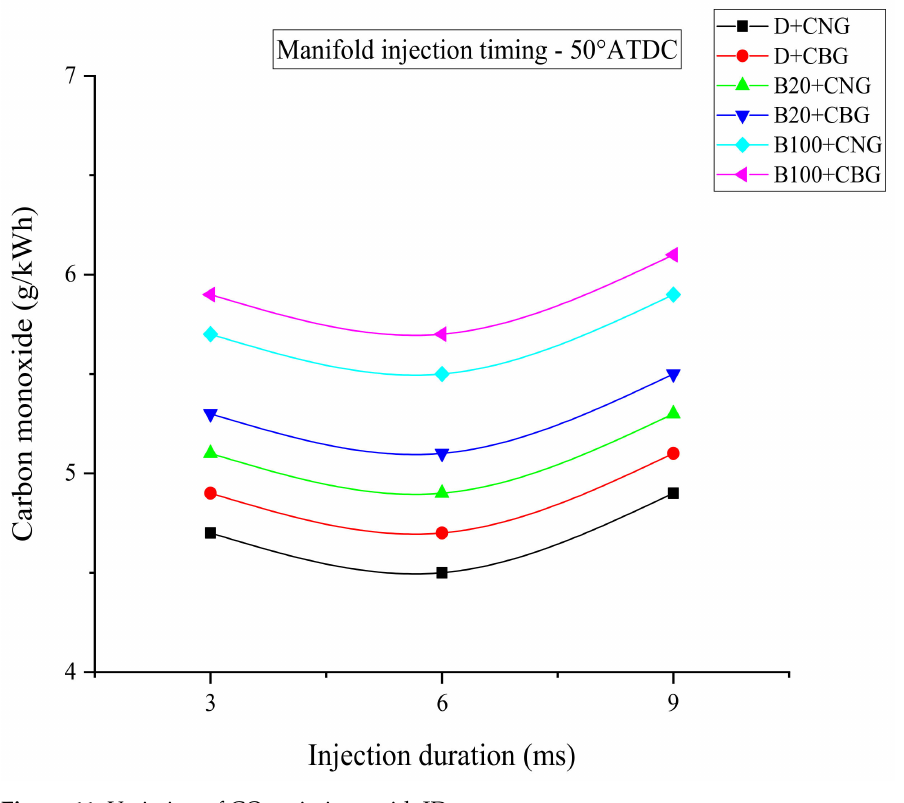
Figure 11. Variation of CO emissions with ID.